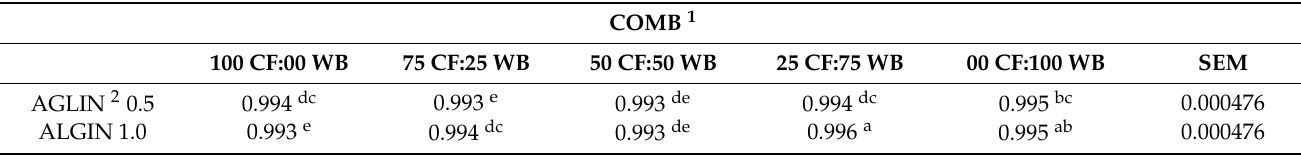
Table 7. Interactive effect of COMB × ALGIN on water activity (a w ) of pet food formulations during a simulated retail display.